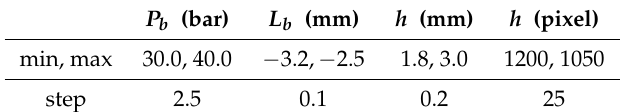
Table 1. Parameters for shock front measurements.